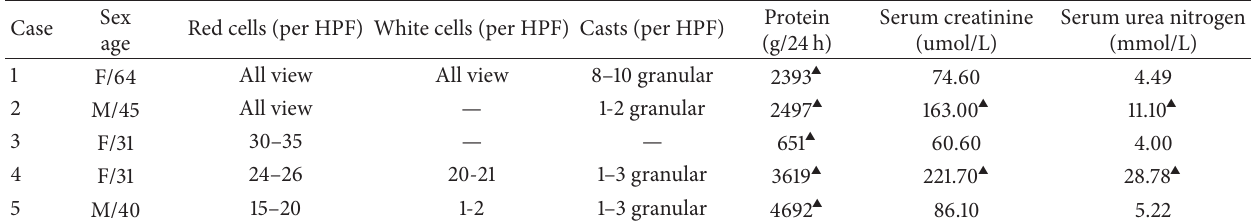
Table 2: Renal involvement of SLE that has nephritis with mainly IgA